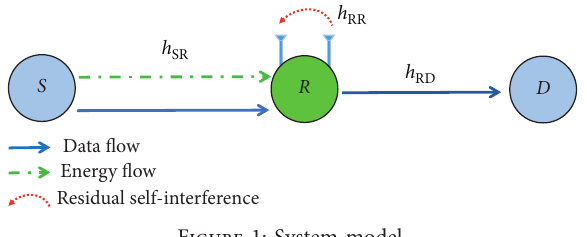
Figure 1: System model.